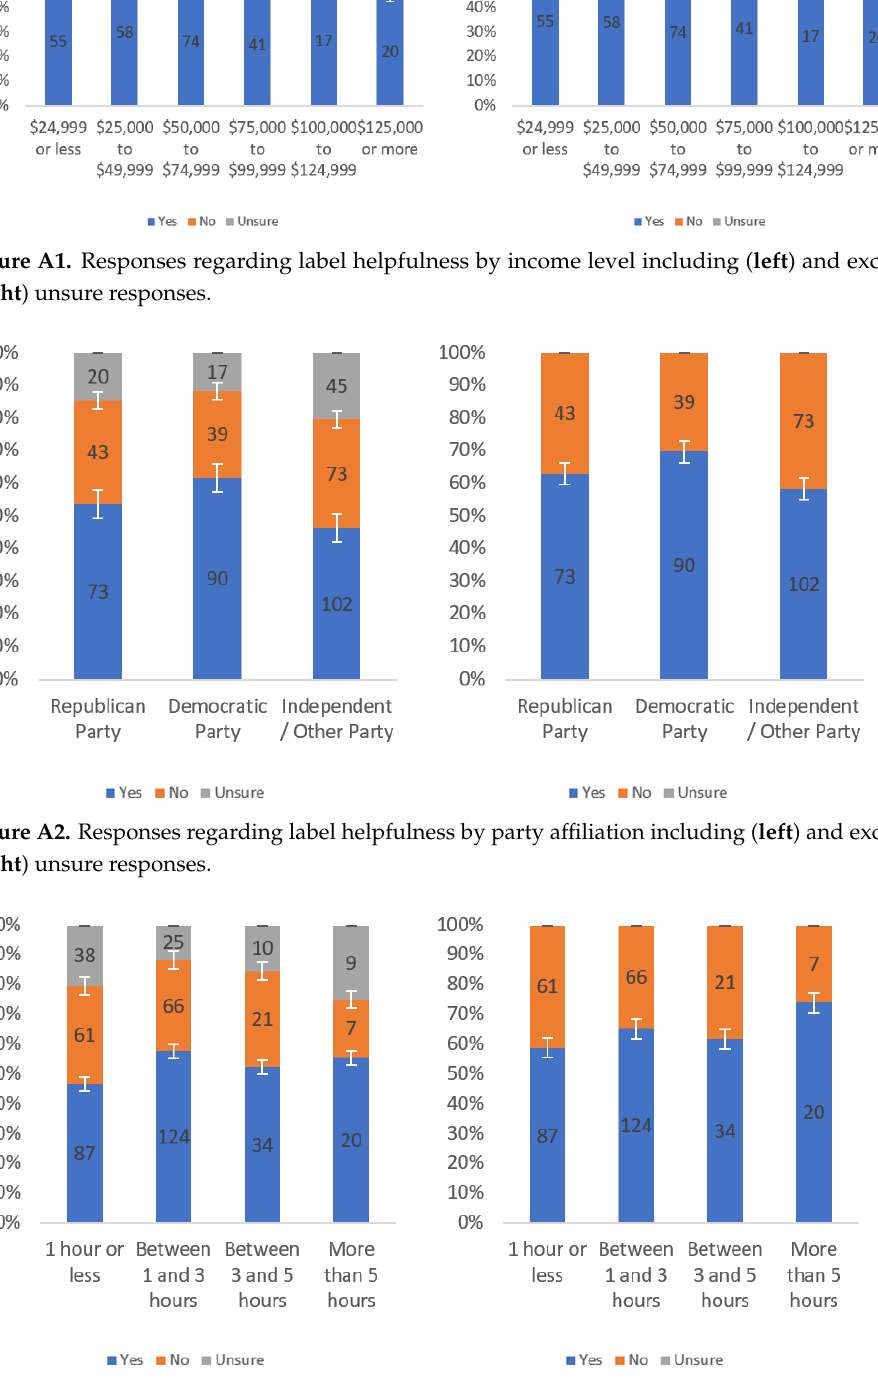
Figure A3. Responses regarding label helpfulness by internet usage level including ( left ) and ex- cluding ( right ) unsure responses.